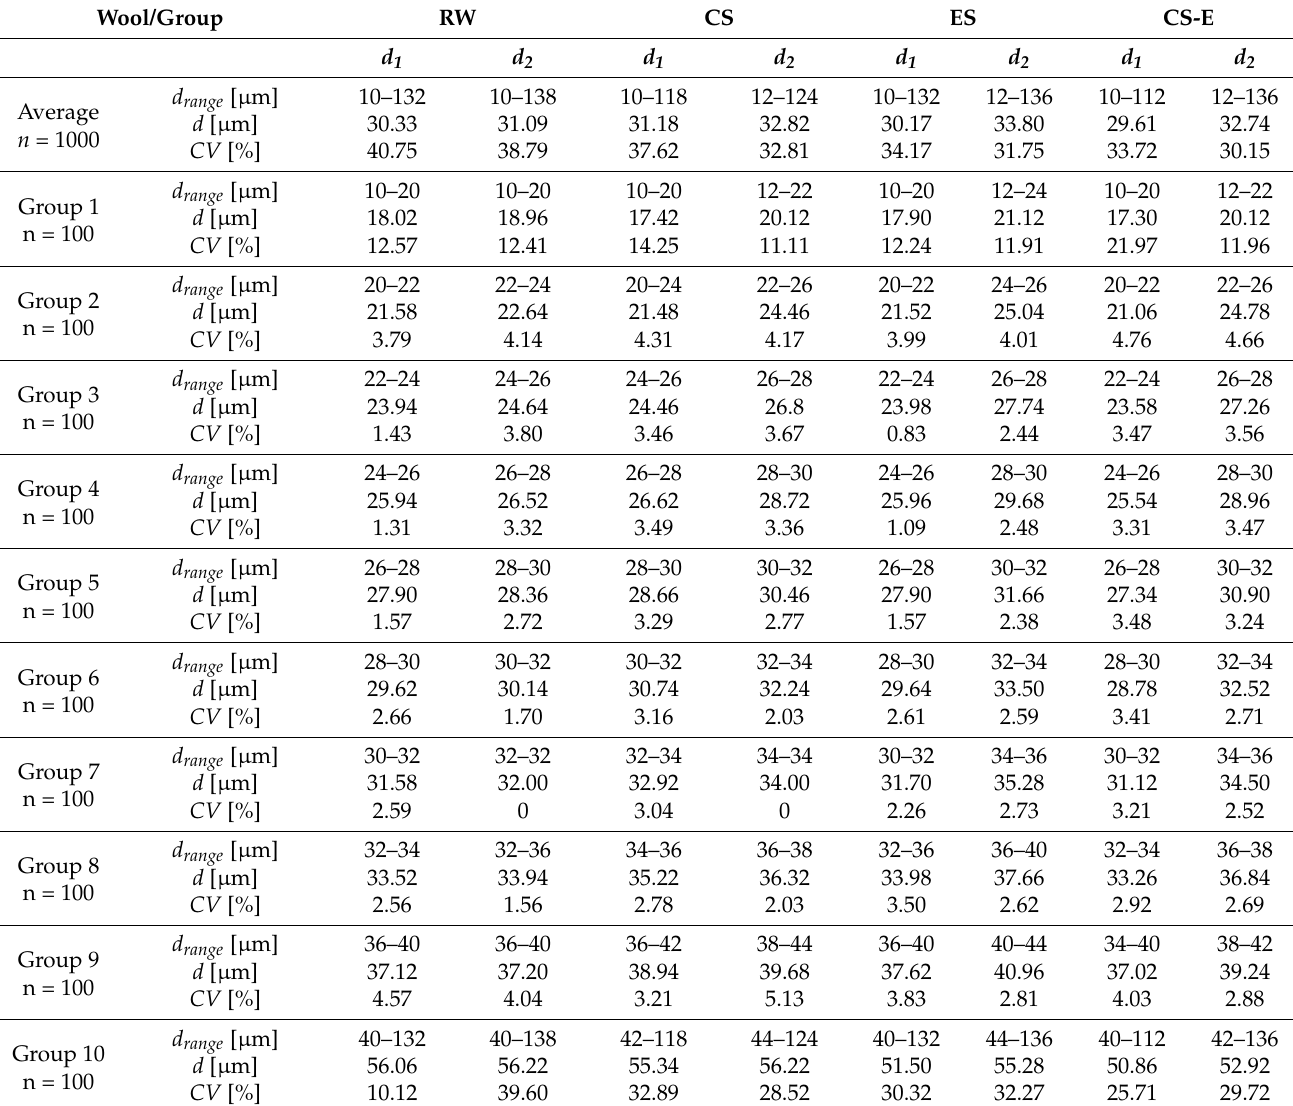
Table 3. Fiber diameter ( d ) of raw and scoured wool before (in cedar oil, d 1 ) and after 24 h swelling in water ( d 2